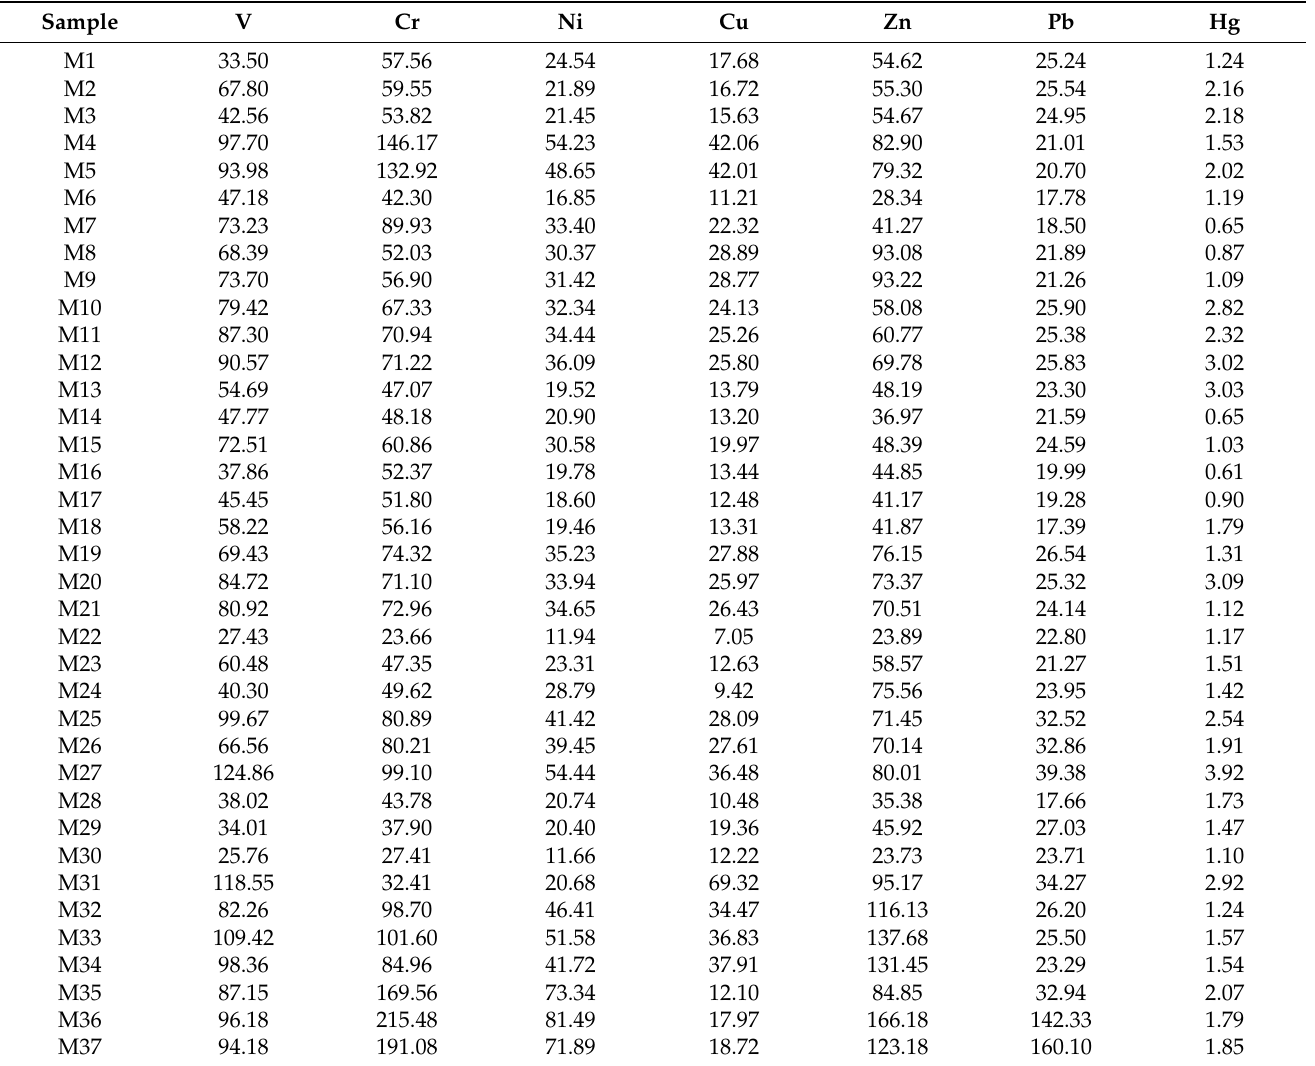
Table A2. The original data of the trace elements analyzed in this